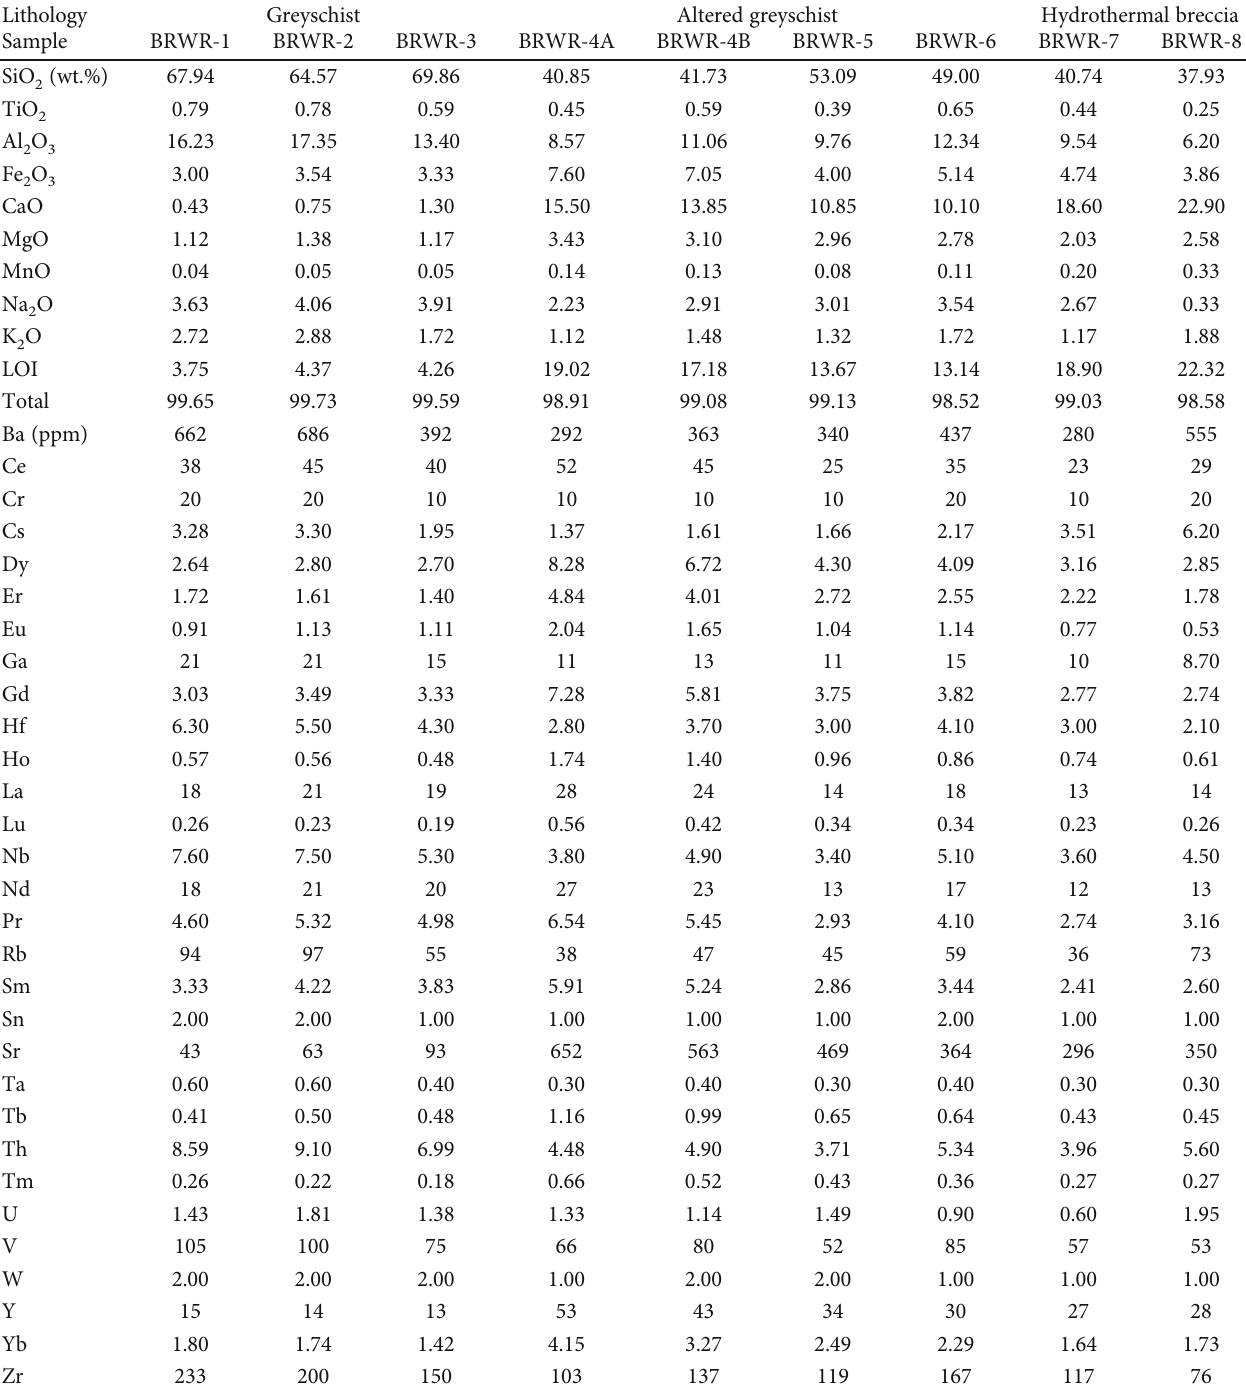
Table 2: Whole-rock major and trace element geochemistry of greyschist, altered greyschist, and hydrothermal breccia from Bruce Rocks. Lithology Greyschist Altered greyschist Hydrothermal breccia Sample BRWR-1 BRWR-2